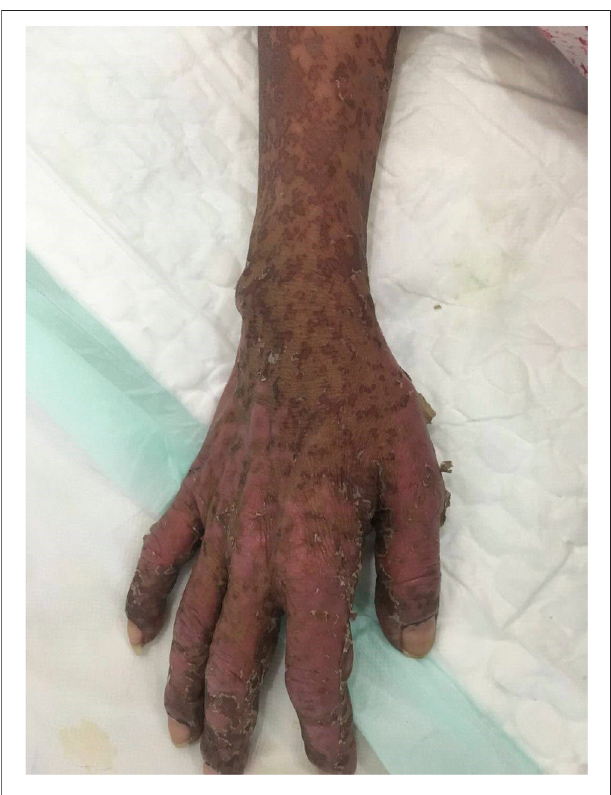
FIGURE 2 | Epidermal exfoliation of upper limbs (BSA less than